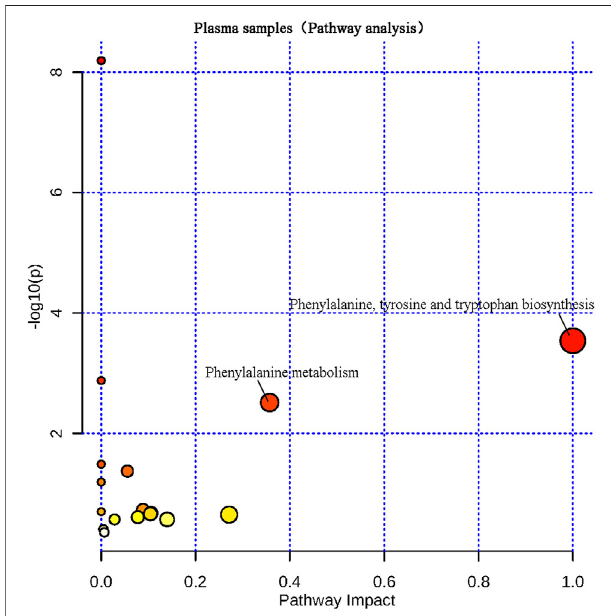
FIGURE 7 | Metabolic pathway analysis of plasma samples.